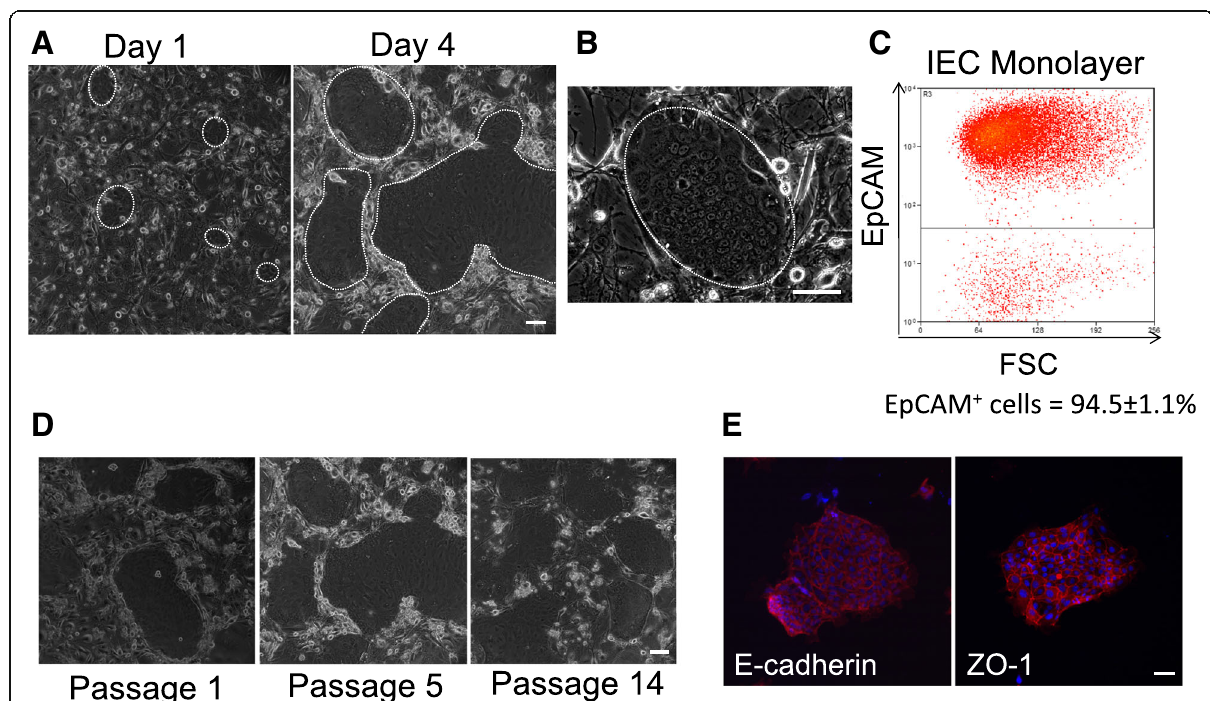
Fig. 1 Mouse small intestinal epithelial cells divide and maintain morphology with passage and express epithelial cell markers when cultured under modified conditional reprogramming conditions. a Representative phase contrast images of IEC monolayer colonies 1 day post-plating and 4 days after post-plating (passage 12). Dashed circle indicates colonies. Images were taken at 10× magnification. Scale bar: 100 μ m. b Representative image of colony with higher magnification (20×) c Representative flow cytometry plot of EpCAM expression in IEC monolayers. Data represents IEC monolayers from 3 individual mice and diverse passages. d Representative phase contrast images of IEC monolayers colonies at early, middle and later passages. e Representative fluorescence microscopy images of